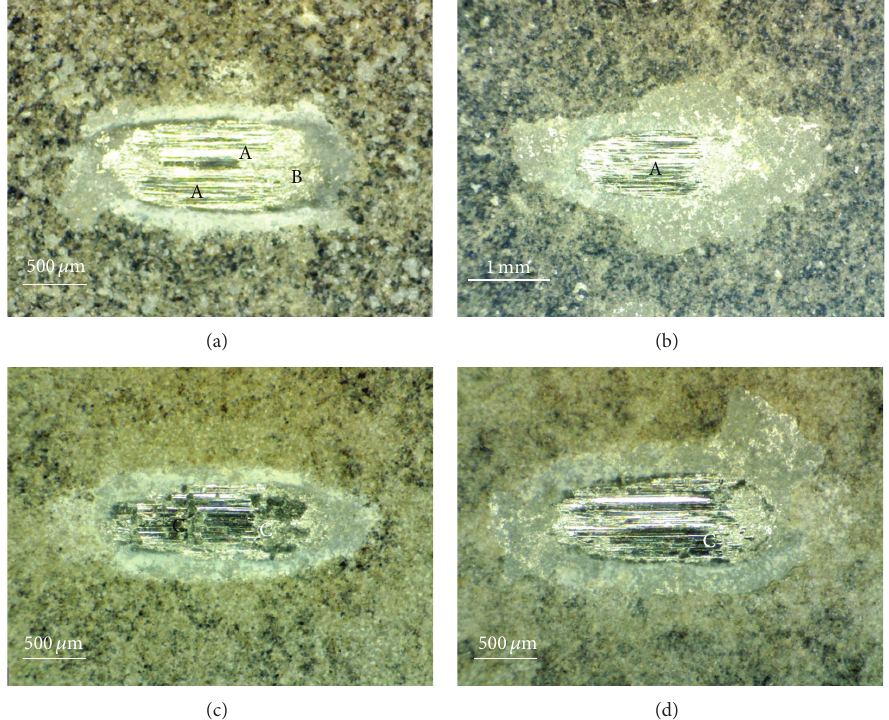
Figure 8: OM images of the four sliding tracks (a) S1 at 20 𝜇 m thickness, (b) S1 at 30 𝜇 m thickness, (c) S2 at 20 𝜇 m thickness, and (d) S2 at 30 𝜇 m thickness under 300 N of pressing load and 50 cycles with marked typical wear failure areas.